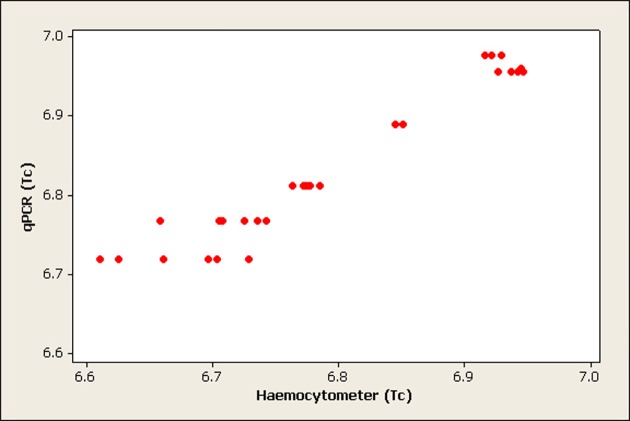
Scatterplot showing the correlation between qPCR and haemocytometer quantification of T. congolense savannah (Tc) in midguts (numbers are presented on log 10 scale and each dot is the average of three replicates).